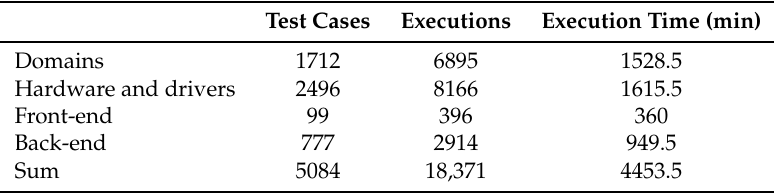
Table 2. Running test cases in DEWESoft continuous integration system.